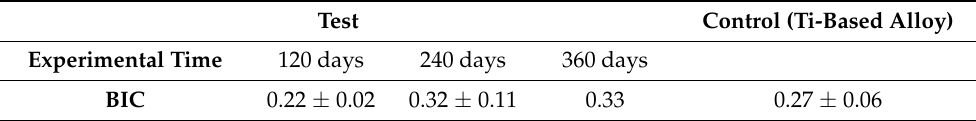
Table 1. Bone–implant contact (BIC) values after various times of implantation.